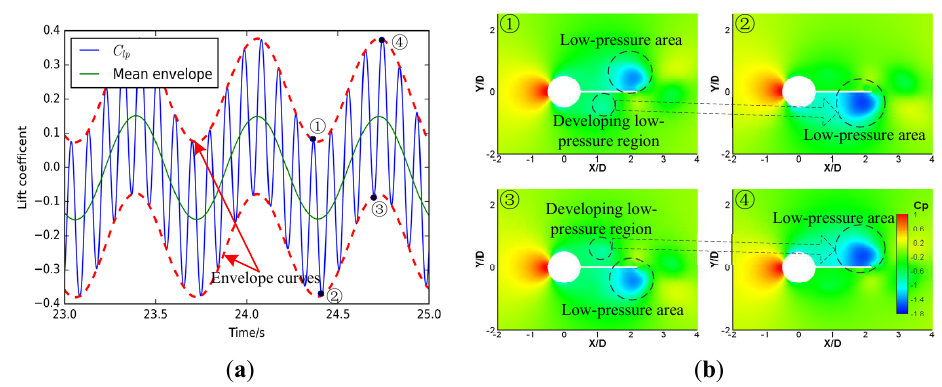
Figure 7. ( a ) Instantaneous lift ( C lp is the lift coefficient on the plate) and ( b ) pressure-coefficient contours around the plate with U = 1.7 m/s and L ∗ = 1.5.